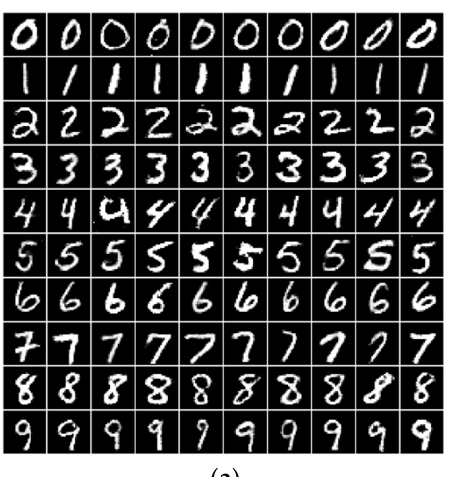
Figure 6. Samples generated by SGAN. ( a ) MNIST. ( b ) Fashion-MNIST.